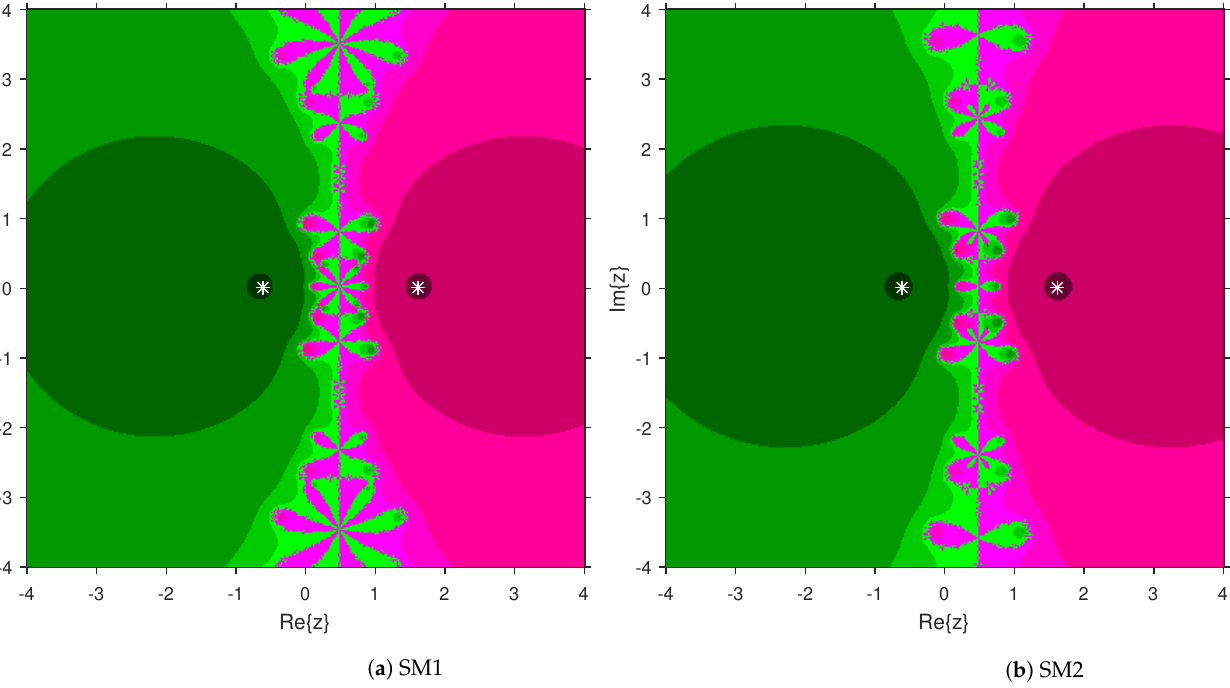
Figure 2. Attraction basins comparison between SM1 and SM2 corresponding to M 2 ( z )